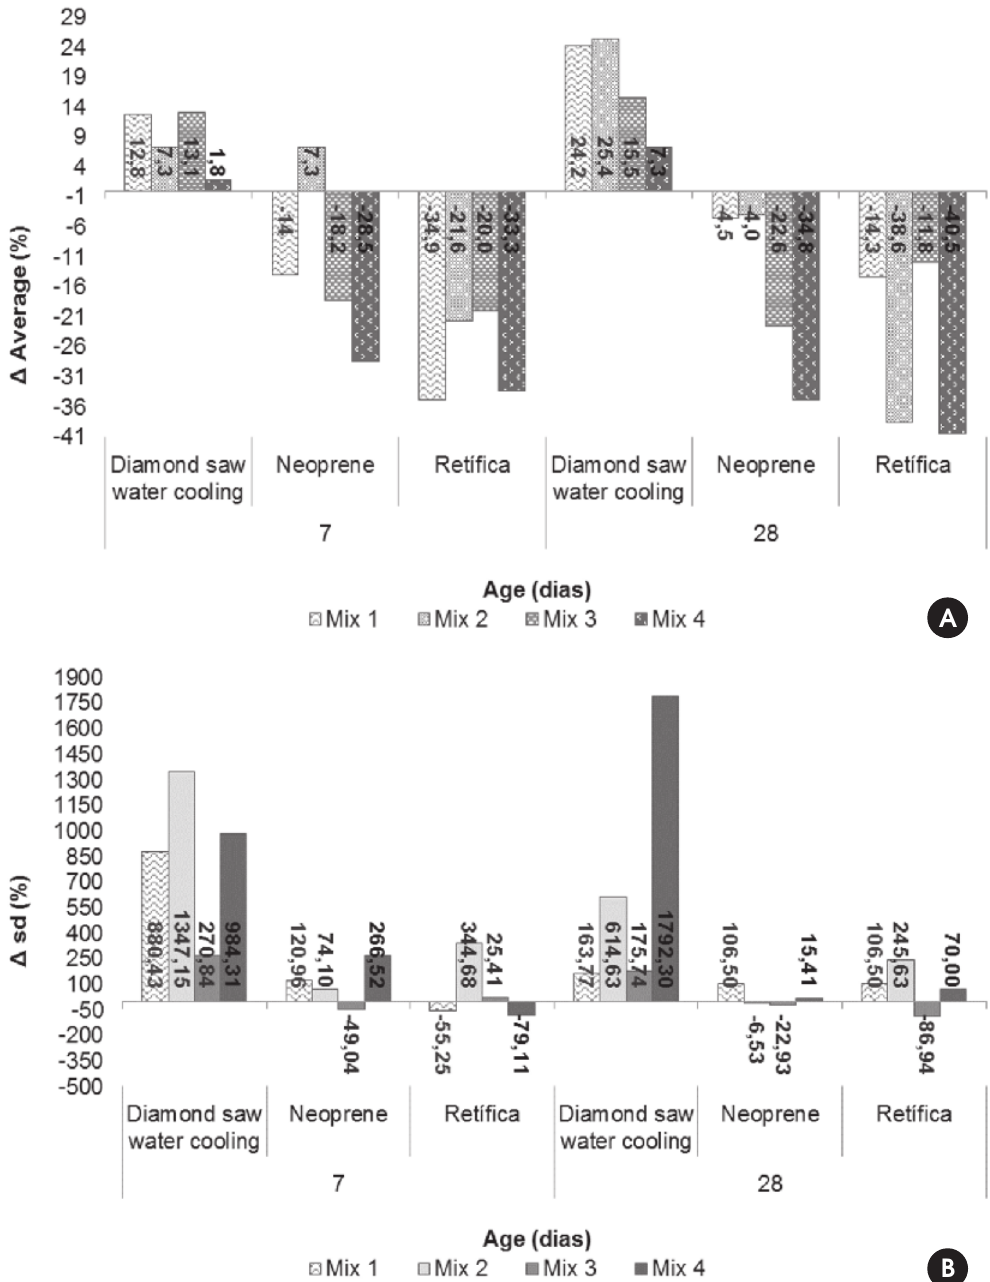
Comparison of surface preparation techniques and the standard established by NM 77. a) Comparison of the mean values. b) Comparison of standard deviation